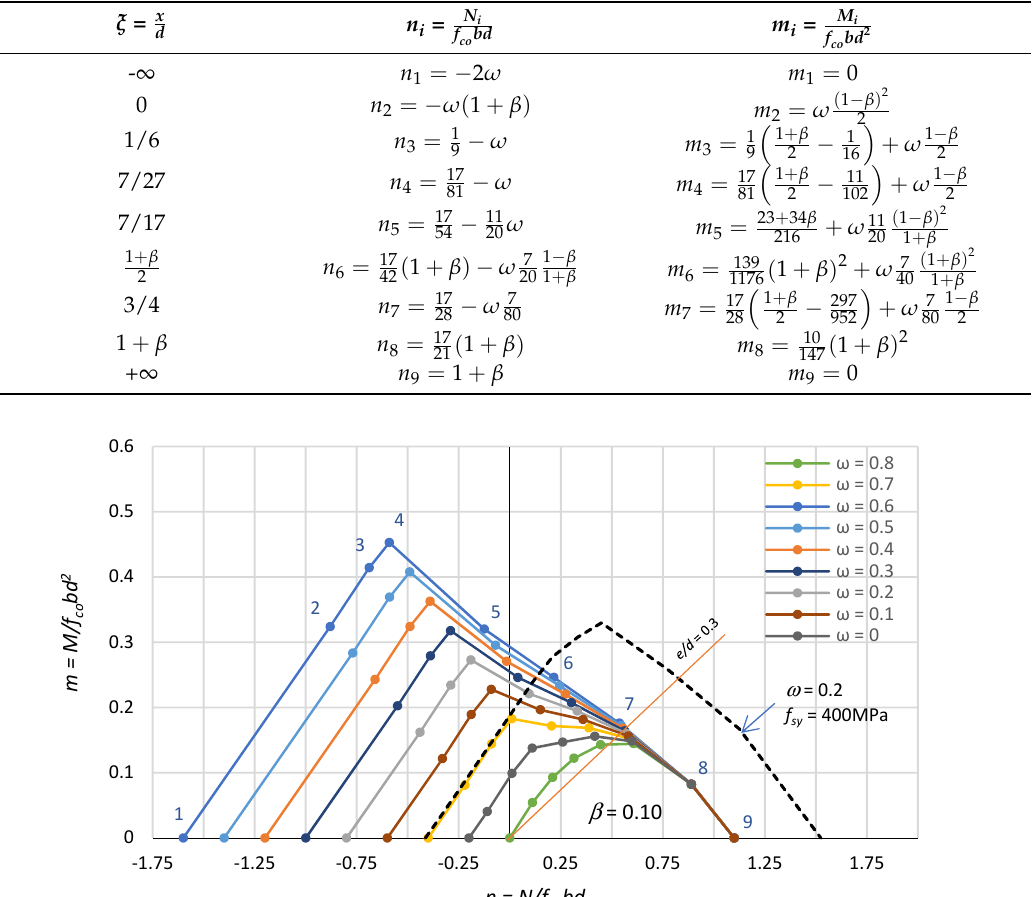
Table 2. Coordinates of the interaction points of the n–m forces without compression bars.